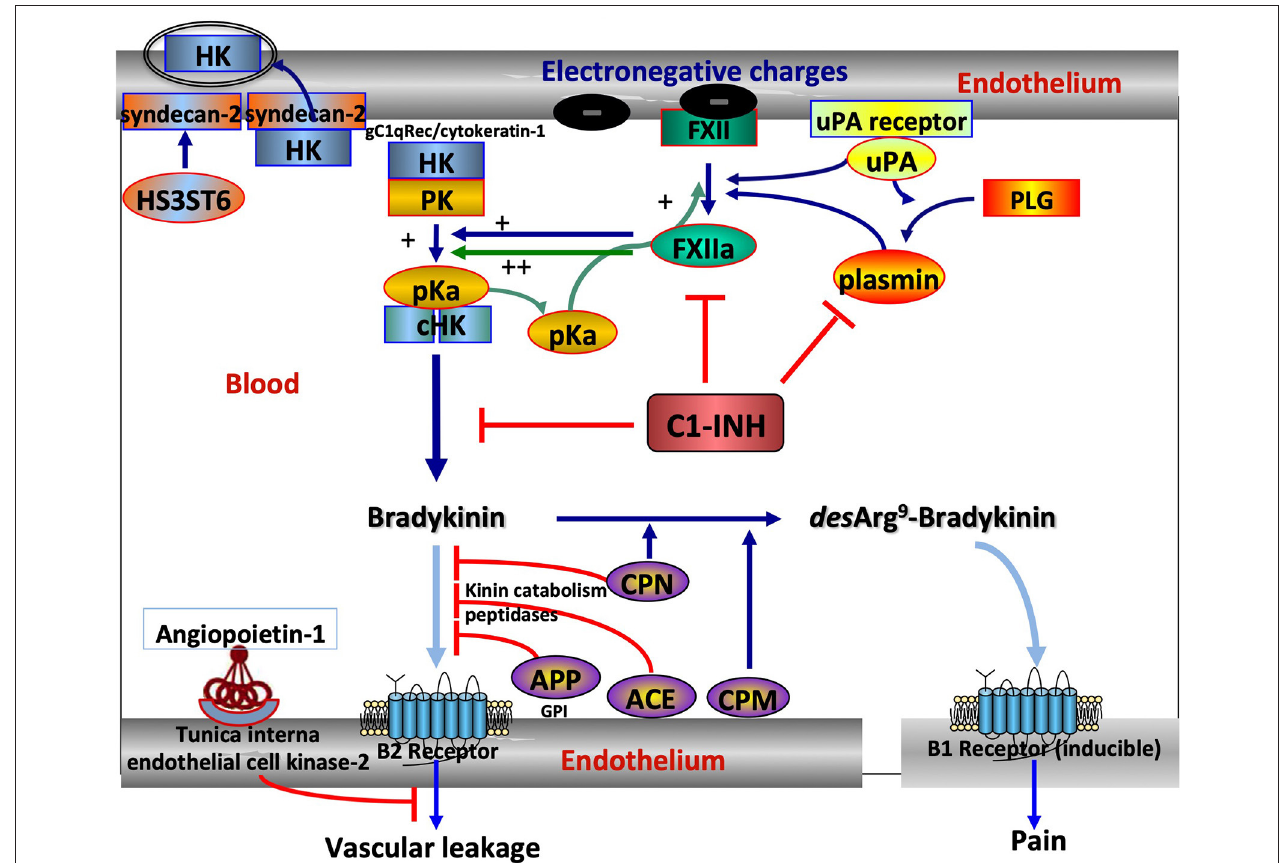
FIGURE 1 | The central position of C1 Inhibitor (C1-INH) within the kallikrein–kinin system (KKS) and its companions. KKS activation is triggered when FXII becomes activated into FXIIa on binding to an activator onto an electronegative membrane. KKS activation results in HK cHK and bradykinin (BK). The serpin C1-INH controls both activation and activity of KKS, with zymogen to enzyme conversion of FXII and pK. C1-INH also controls the reciprocal activation of FXII and pK by plasmin in an interconnected amplification ( 5). ANGPT1 is a secreted protein ligand for tunica interna endothelium kinase-2, a receptor expressed in growing vascular endothelial cells. ANGPT1 targets key mechanisms contributing to the maintenance of endothelium function by inhibiting the effects of permeability enhancing agents, including BK, protecting from extensive permeability. H3ST6 is involved in HK docking on the endothelial cell surface, preventing HK binding to gC1q receptor and cytokeratin-1 and engaging in kinin forming. Aminopeptidase P (APP) and Angiotensin-I converting enzyme (ACE) are the membrane peptidases that inactivate BK, whereas carboxypeptidases M and N transform a B2 ligand into a B1 ligand. What this scheme means for understanding hereditary angioedema (HAE). SERPING1 variants display a markedly reduced control function of C1-INH toward KKS and plasmin. F12 and PLG variants are shown to increase FXII and plasminogen (PLG) activation, respectively, and KNG1 variants more susceptible to HK cleavage with BK production. ANGPT1 variants showed reduced capacity to bind its natural receptor, with less control of BK-dependent vascular leakage. Because of incomplete heparan-sulfate modification of syndecan-2 by H3ST6, H3ST6 variants were less able to take up HK via endocytosis into the endothelial cell and more HKs entering into the KKS process. Dark blue arrows indicate activation, green arrows the amplification loop, light blue arrows the ligand–receptor interactions, and red lines indicate an inactivation of BK function. FXII, Factor XII; pK, prekallikrein; pKa, plasma kallikrein; HK, High-molecular-weight kininogen; cHK, cleaved HK; ANGPT1, angiopoietin-1; H3ST6, Heparan-sulfate-glucosamine 3- O -sulfotransferase 6; uPA, urokinase-type plasminogen